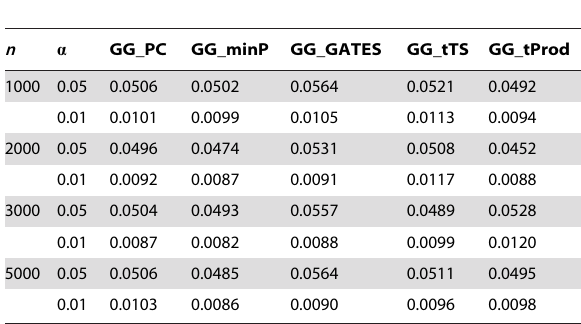
Table 1. Empirical, simulation-based type I error rates of proposed GGG